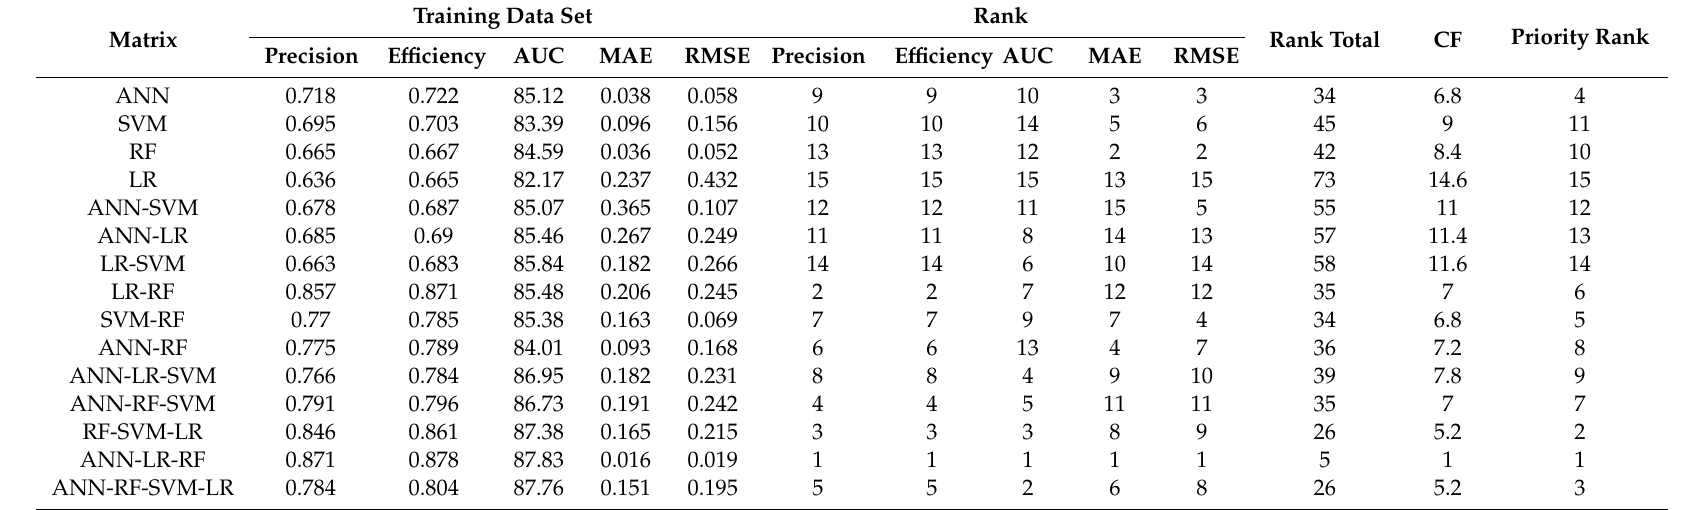
Table 4. Results of validation techniques and accuracy prioritization based on training